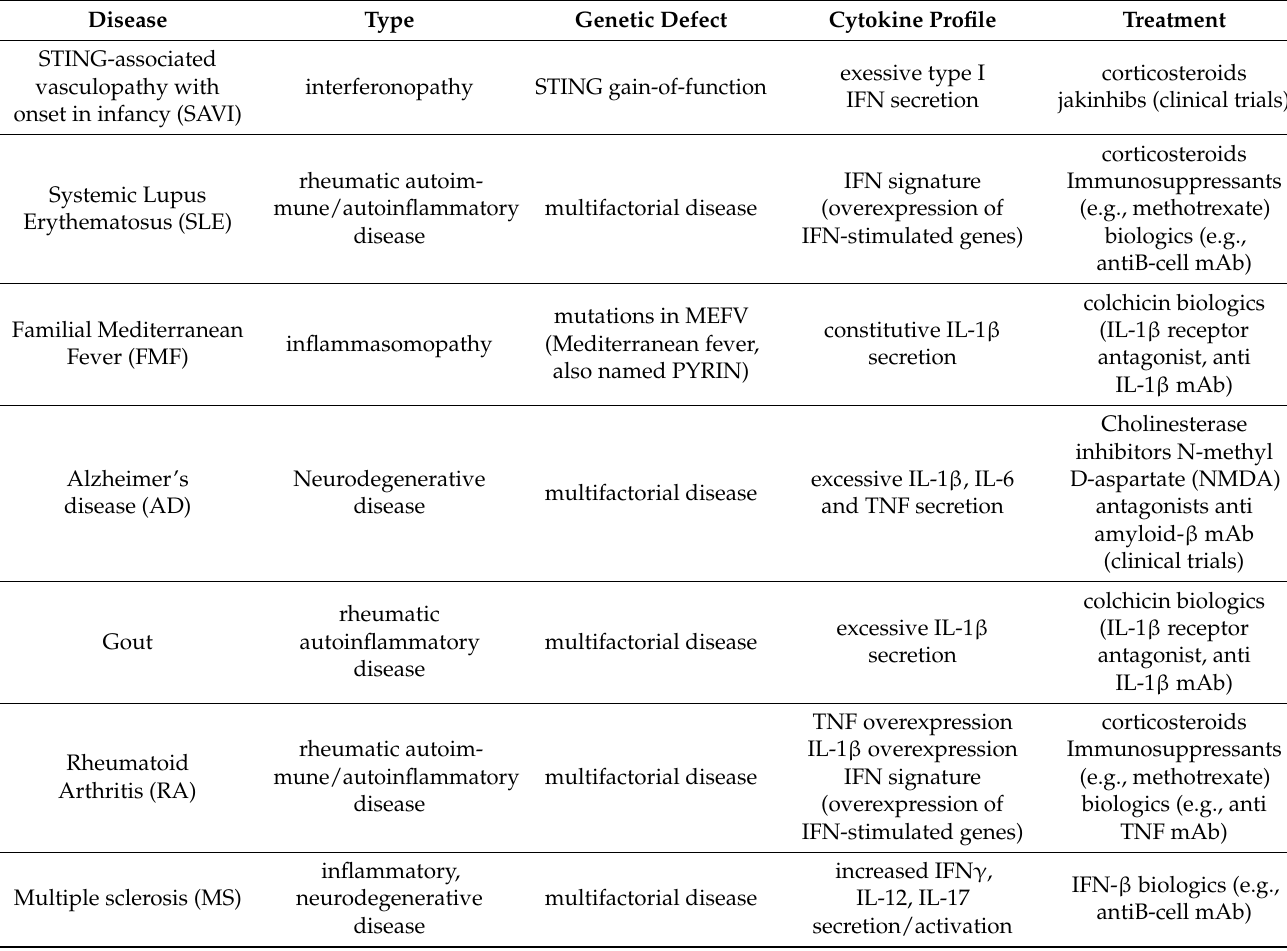
Table 1. Type I IFNs- and IL-1 β -mediated pathologies discussed in this